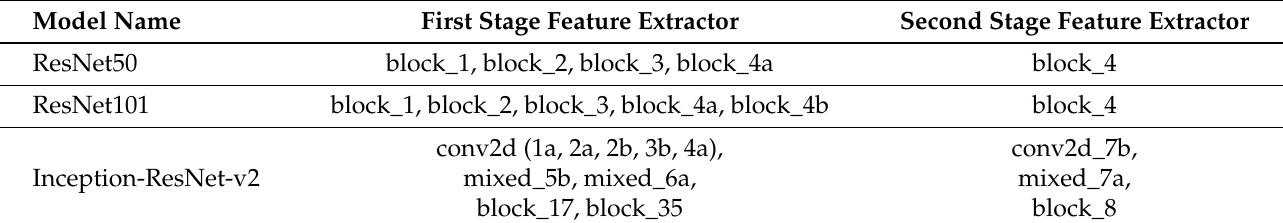
Table 2. Extracted feature layers.